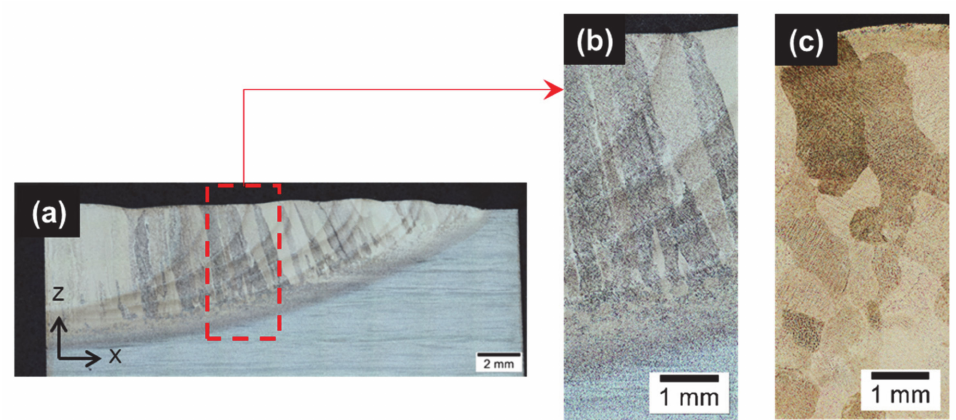
Figure A1. ( a ) Overview of half deposit in as-built conditions with enhancement of HAZ (dark curved areas) and large nugget in the center (light area) (Reprinted with permission from ref. [5]. Copyright 2015 Elsevier); ( b ) close-up view of the inset within ( a ), showing the prior columnar β grains in the as-built deposit; ( c ) β columnar grains turned into equiaxed due to recrystallization after furnace reheating to 1000 ◦ C/30 (cid:48) and later transformed into α (cid:48) due to subsequent water